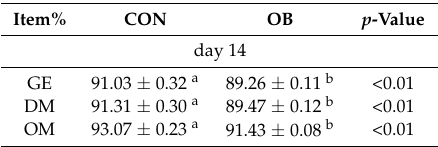
Table 2. Nutrient digestibility of pigs fed either control or oat bran diet on day 14 and day 28 of the experimental period 1